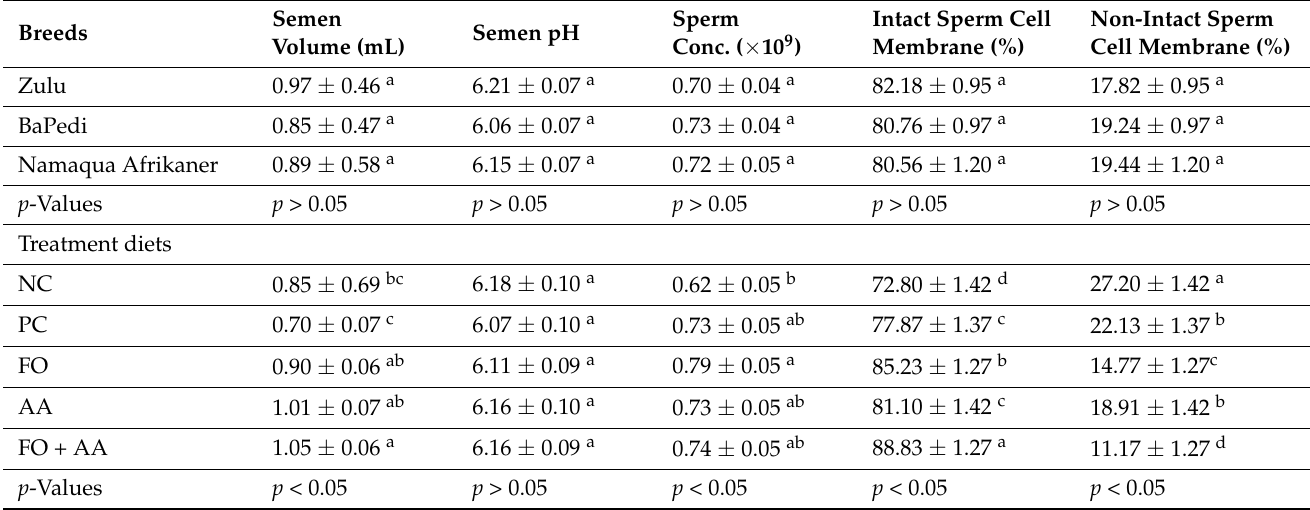
Table 3. The effect of breed and the dietary flaxseed oil and ascorbic acid on semen